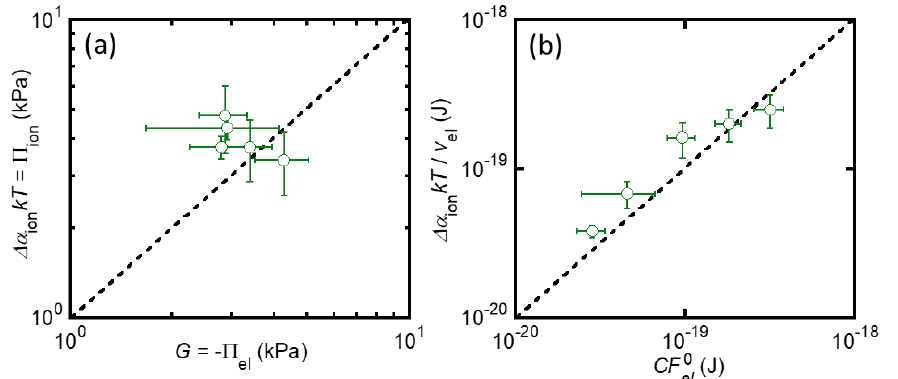
Figure 5. Relationships between elastic pressure and the ionic osmotic pressure of the St-tetra-PEG gels; (a) G vs. ∆ α ion kT (macro scale) and (b) CF 0 gels; (a) G vs. Δ𝛼 ion 𝑘𝑇 (macro scale) and (b) 𝐶𝐹 el0 vs. Δ𝛼 ion was experimentally determined through the potential measurement. Δ𝛼 ion was experimentally determined through the potential measurement.